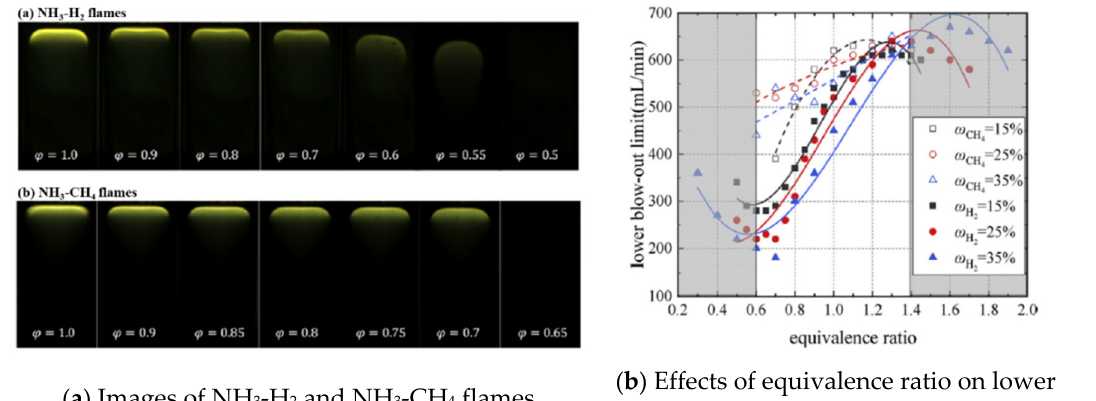
Figure 12. Flame observation and effects of equivalence ratio on blowout limit: ( a ) NH 3 -H 2 and NH 3 -CH 4 flames extinguishing with decreasing equivalence ratio; ( b ) Blowout shape according to equivalence ratio on variable H 2 and CH 4 flow. Courtesy of Elsevier [68].